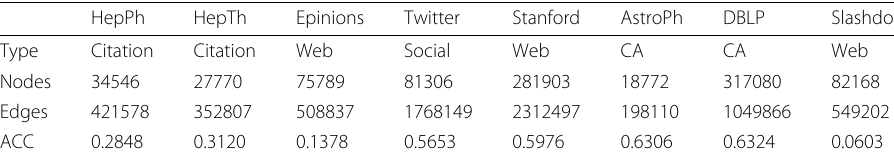
Table 2 Description of real-world network data